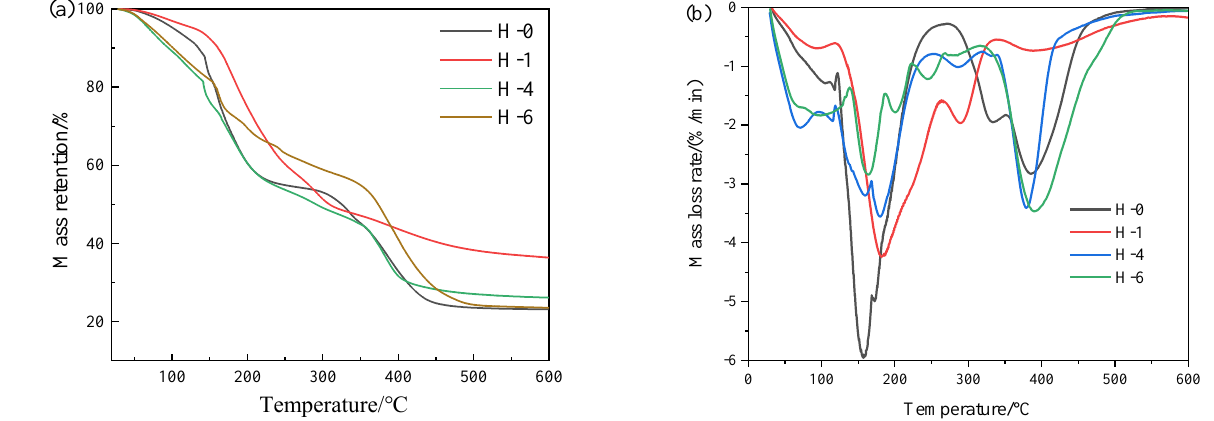
Figure 8. TG curves ( a ) and DTG curves ( b ) of transparent flame-retarded hydrogels. Table 2. TG data of transparent flame-retarded hydrogels. ( T d represents the initial degradation temperature when mass loss is 50%, PMLR stands for peak quality loss rate, T max represents the maximum mass loss rate temperature.).